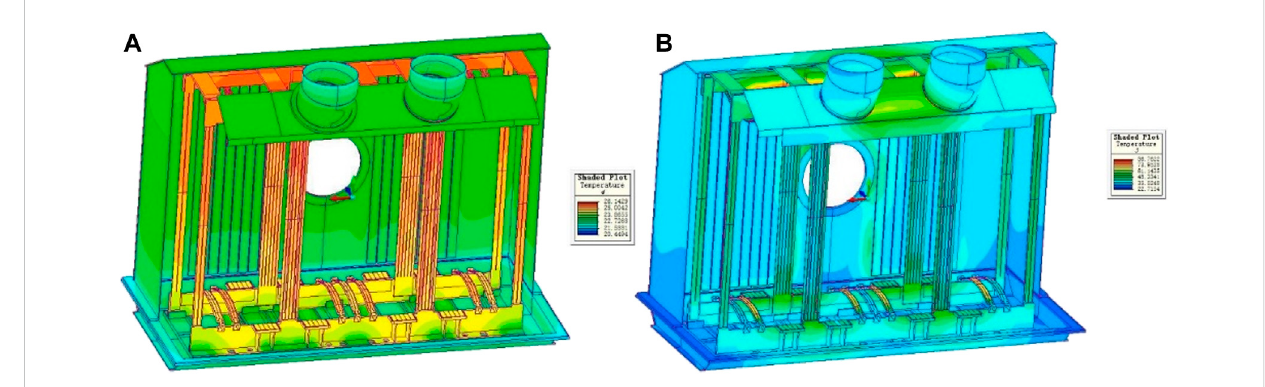
FIGURE 4 Cloud Map of Temperature Field Distribution in Oil Tank with Coupled Thermal Field at 20 ° C (A) 5% capacity (B) 85% capacity.